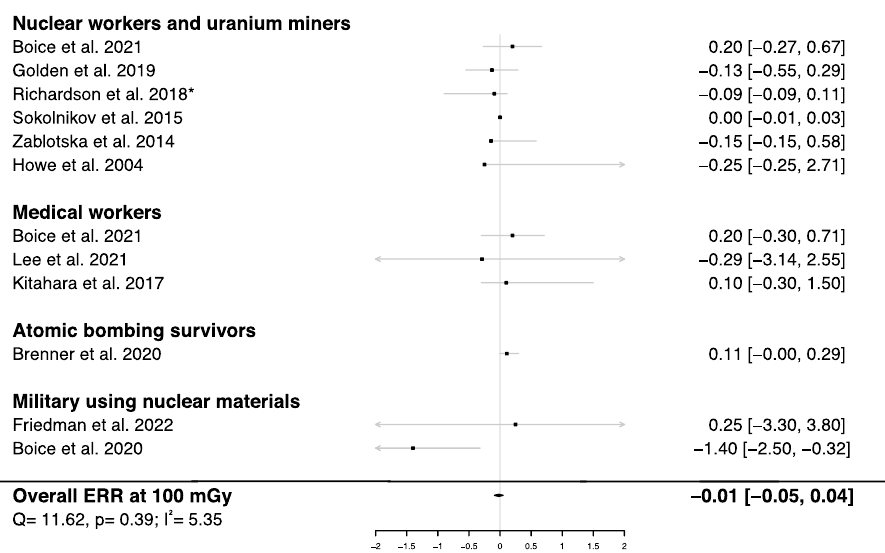
Figure 2. Excess relative risk (ERR) and 95% confidence interval (CI) for brain/CNS tumor death in relation to IR-exposure. *90% CI. We calculated an ERR per Gy with a 95% CI for the Richardson study and this does not change the outcome of this